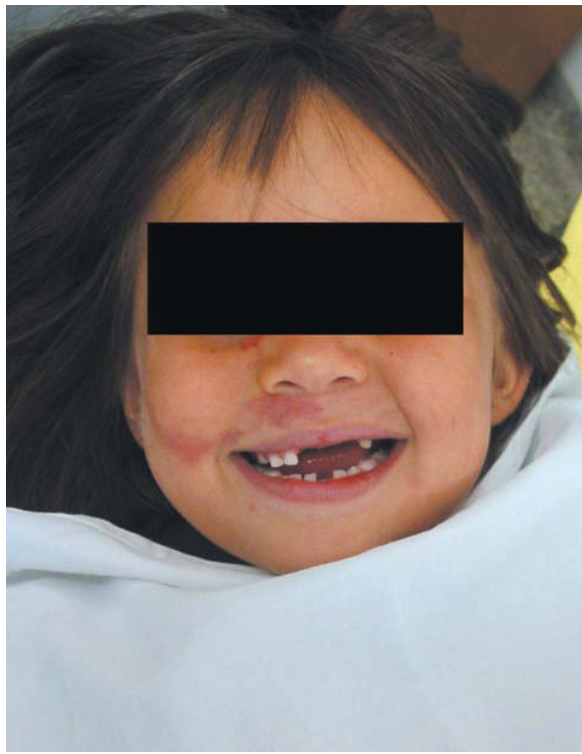
FIGURE 1- Extraoral aspect of the child with